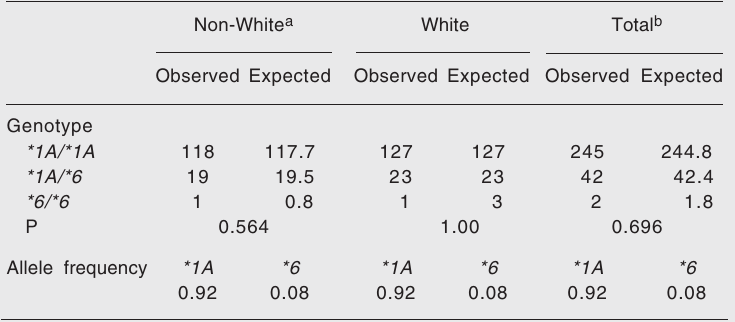
Table 6. CYP2E1 genotypes and allele frequencies (allele *6 ) in white and non- white Brazilian